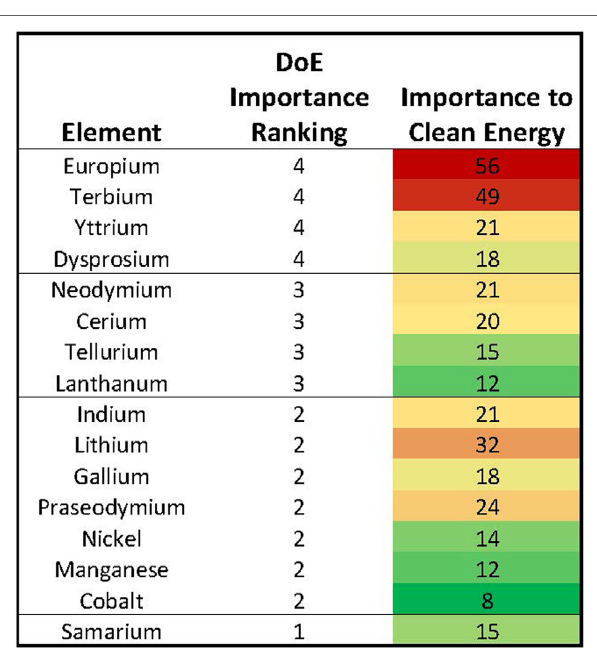
FigUre 8 | The importance rankings as determined by SRI methodology. Red denotes more important, while green denotes less important. Results from the clustering algorithms matched the expert-produce high and low importance